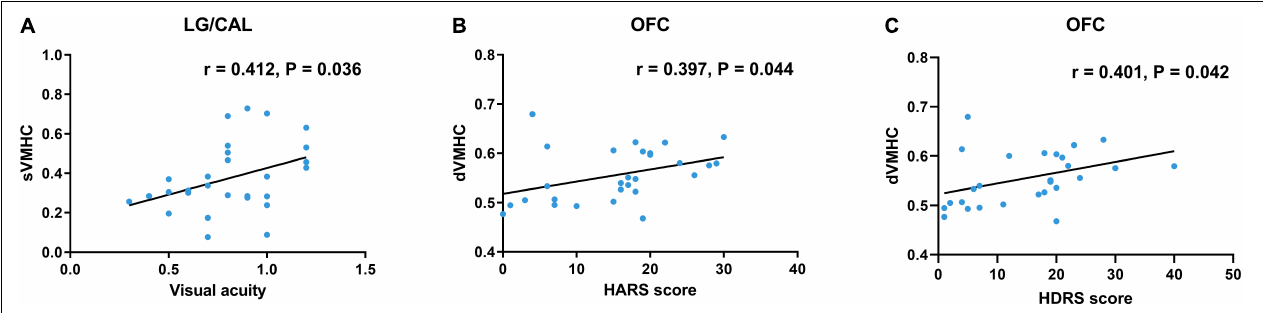
FIGURE 3 | Scatter diagrams show the significant correlations with clinical and neuropsychological assessment in TAO patients. (A) Static VMHC in LG/CAL was positively correlated with visual acuity ( r = 0.412, P = 0.036). (B) Dynamic VMHC in OFC was positively correlated with HARS score ( r = 0.397, P = 0.044). (C) Dynamic VMHC in OFC was positively correlated with HDRS score ( r = 0.401, P = 0.042). Age and gender were included as covariates. TAO, thyroid-associated ophthalmopathy; VMHC, voxel-mirrored homotopic connectivity; LG, lingual gyrus; CAL, calcarine; OFC, orbitofrontal cortex; HARS, Hamilton Anxiety Rating Scale; HDRS, Hamilton Depression Rating Scale; sVMHC, static VMHC; dVMHC, dynamic